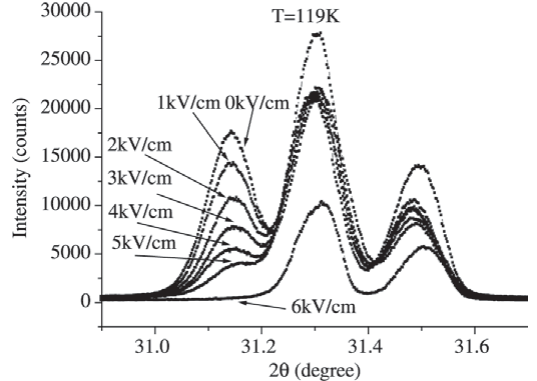
Figure 2. X-ray diffraction pattern for KDP obtained in the ferroelectric phase under electric field from 0-6 kV/cm.